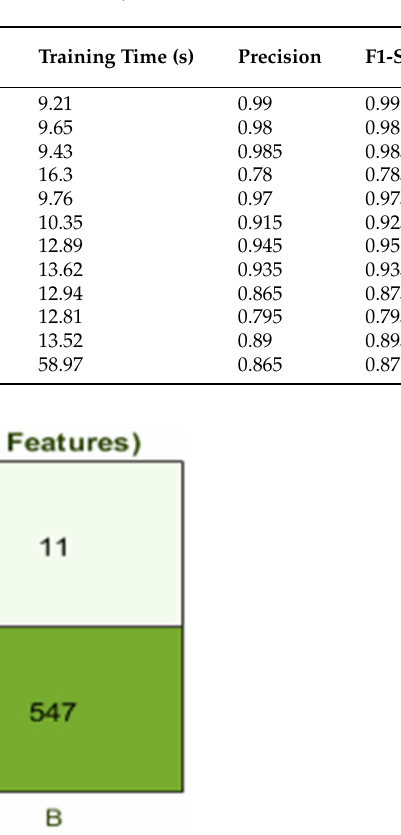
Table 4. Experiment_1 using 5 Folds (3045 Feature).